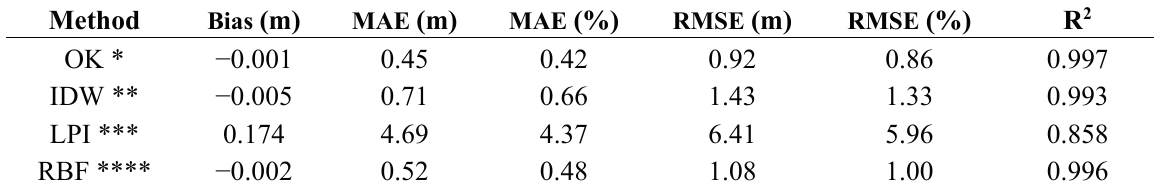
Table 3. Summary of LOOCV